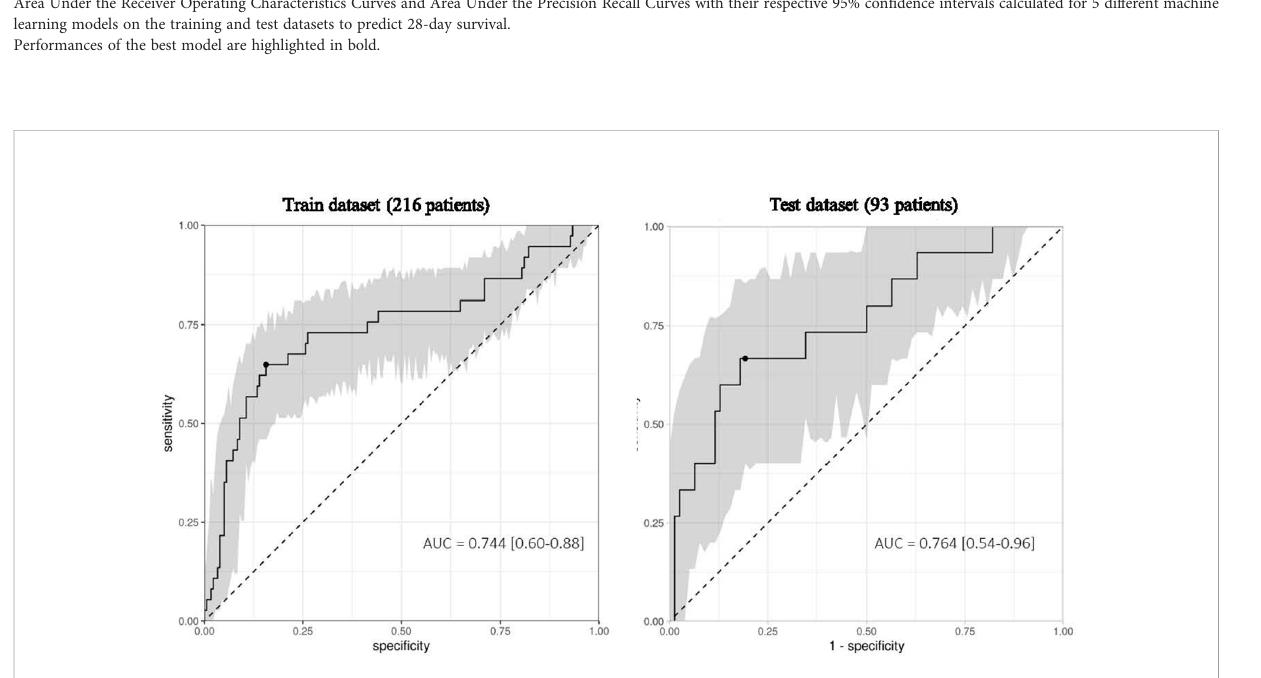
FIGURE 3 IPP markers measured at admission predict 28-day mortality in critically ill COVID-19 patients. Area Under the Receiver Operating Characteristics curve (AUC) calculated on the training dataset of 216 patients and the independent test set of 93 critically ill COVID-19 patients using the 9-mRNA panel at their admission in the ICU. The 95% con fi dence interval (grey) was calculated using bootstrap with 1000 repetitions.